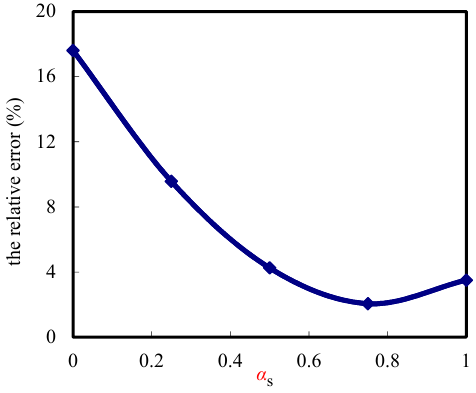
Figure 9. The two-phase permeability average relative errors of core 24 # .